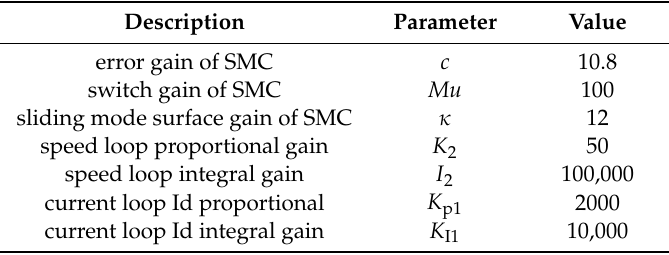
Table 3. The cascade sliding mode control (SMC) controller.